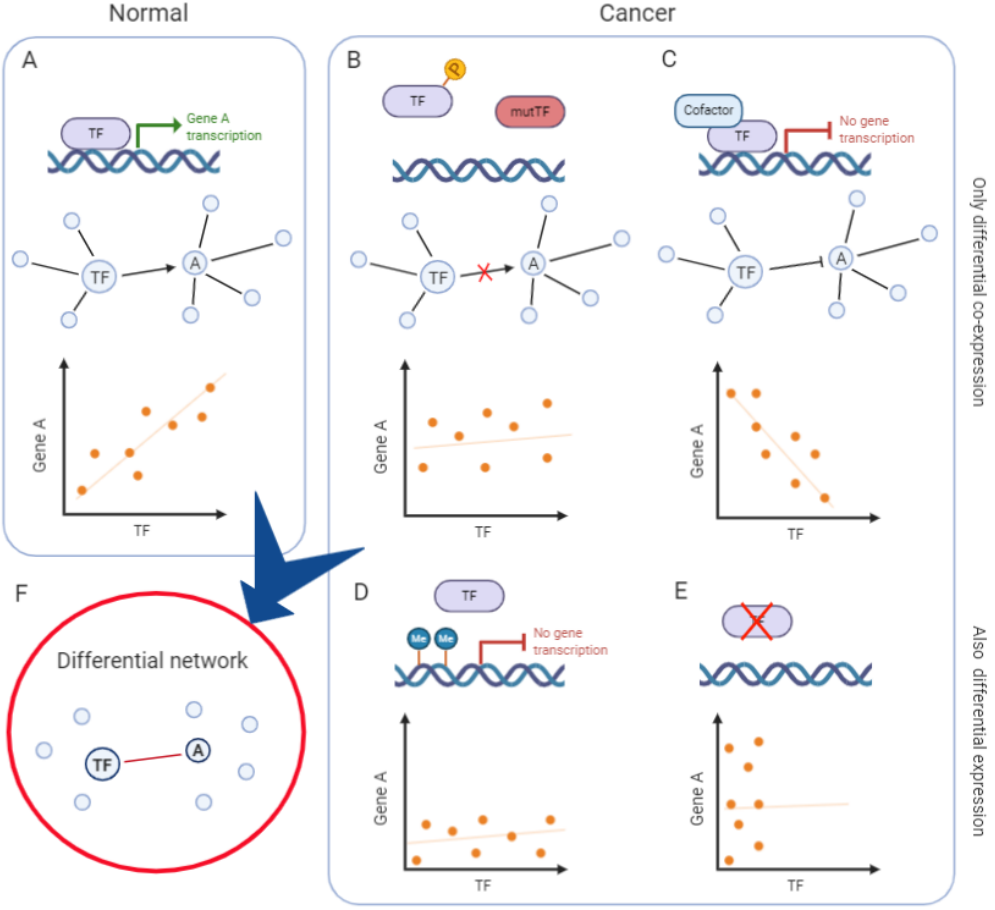
Figure 2. Mechanisms underlying di ff erential co-expression and their impact on transcripts’ correlation. Example of a simplified network in normal tissue ( A ) and in cancer ( B – E ), whose comparison leads to defining a di ff erential network ( F ). ( A ) Example of a simplified co-expression network in normal tissue, with a transcription factor (TF) activating its target, gene A. The TF and A are connected by an edge and their expression is positively correlated. ( B ) Post-translational modifications (e.g., phosphorylation) or mutations of the TF impede its binding to gene A promoter. Hence, the TF does not activate gene A expression: they are not transcriptionally correlated and